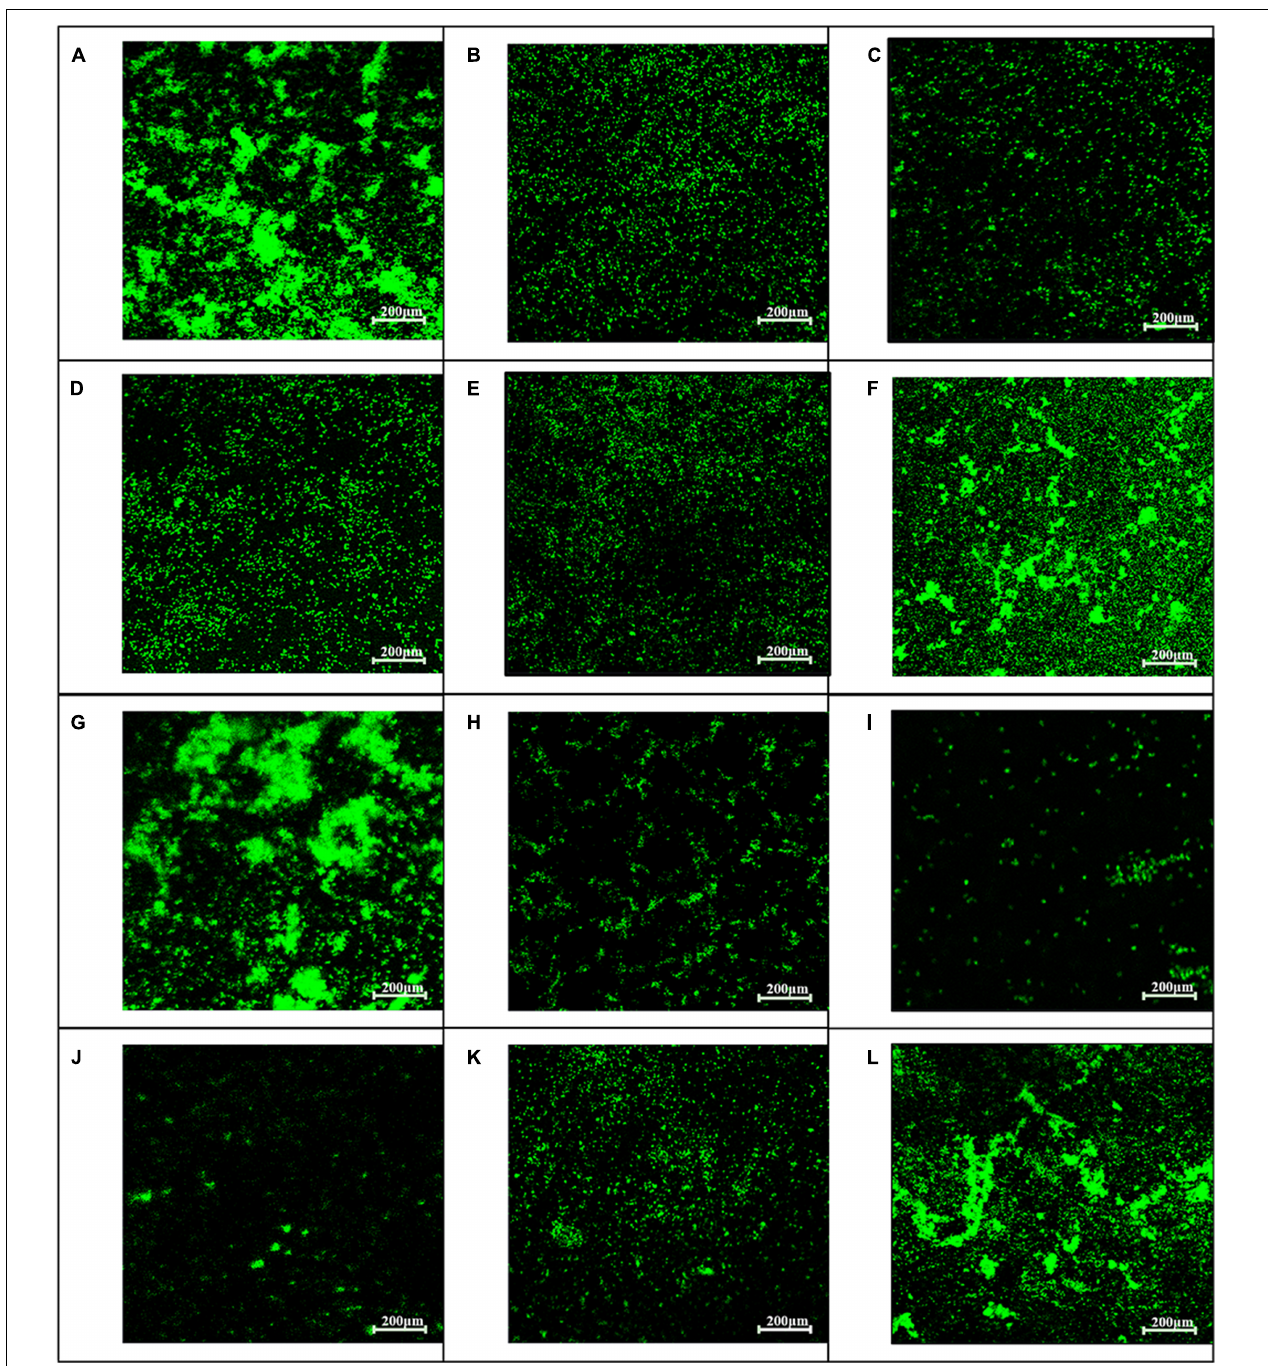
FIGURE 5 | Influence of baicalin on biofilm formation assessed by fluorescence microscopy (200 × ). Static biofilms after exposure to baicalin or verapamil for 24 h (A–F) and 48 h (G–L) were stained with SYTO 9. ARSS within biofilms on glass carriers display green fluorescence. Control group (A,G) ; verapamil group (B,H) ; 250 mg/L baicalin group (C,I) ; 125 mg/L baicalin group (D,J) ; 62.5 mg/L baicalin group (E,K) ; 31.25 mg/L baicalin group (F,L)